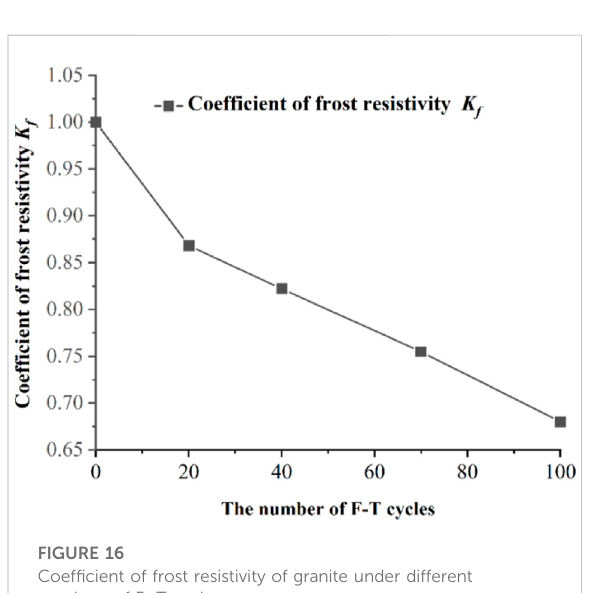
FIGURE 16 Coef fi cient of frost resistivity of granite under different numbers of F – T